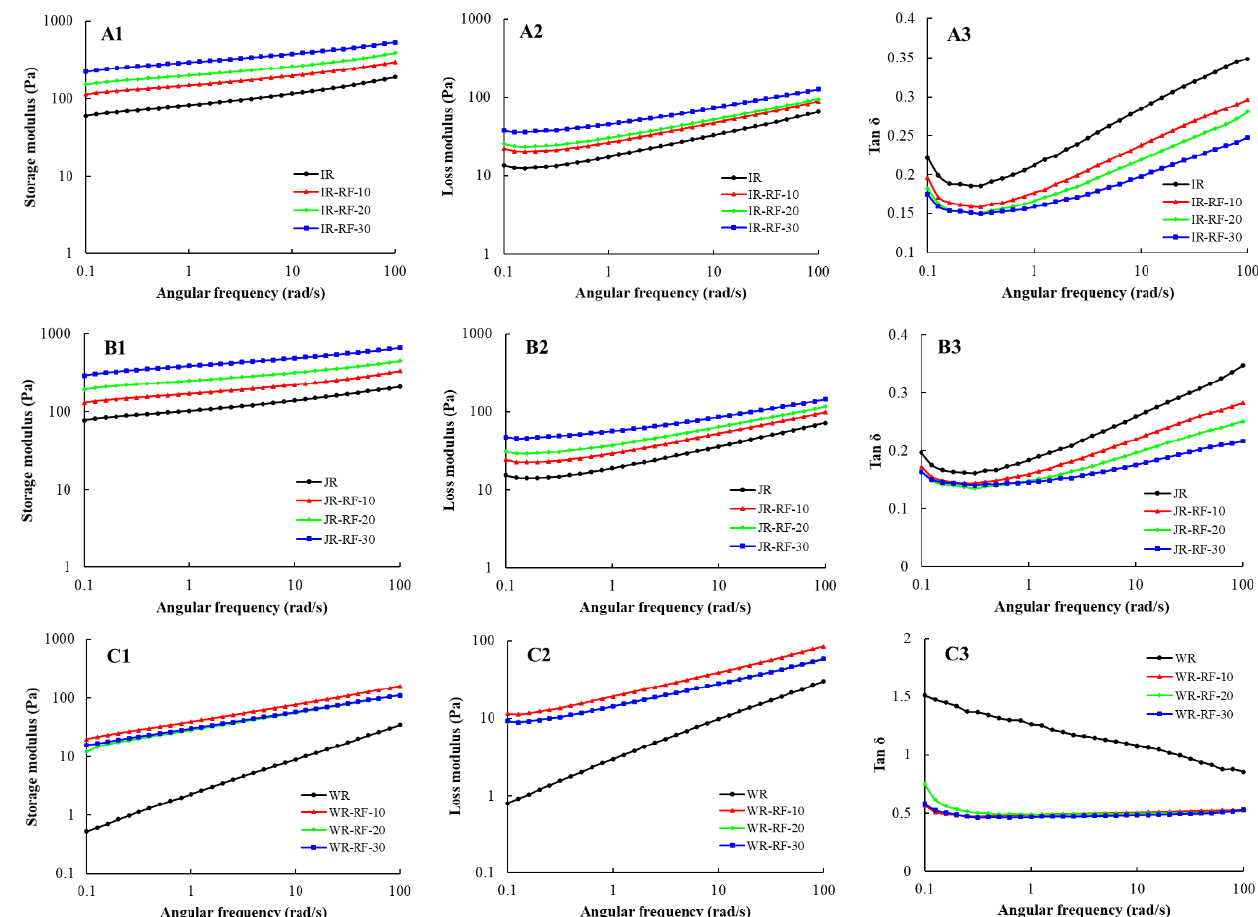
Figure 5. The dynamic viscoelastic properties of untreated and RF-treated rice. ( A1 – A3 ): storage modulus (G'); ( B1 – B3 ): loss modulus (G''); ( C1 – C3 ): tan δ ; IR: indica rice; JR: japonica rice; WR: waxy rice.